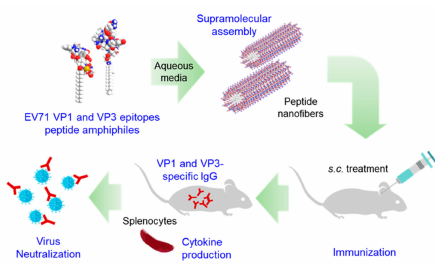
Figure 1. Experimental design to evaluate the self-assembly of Enterovirus 71 (EV71) virus particle 1 (VP1) and virus particle 3 (VP3) multi-epitope peptide amphiphiles and to analyze their immunogenicity in